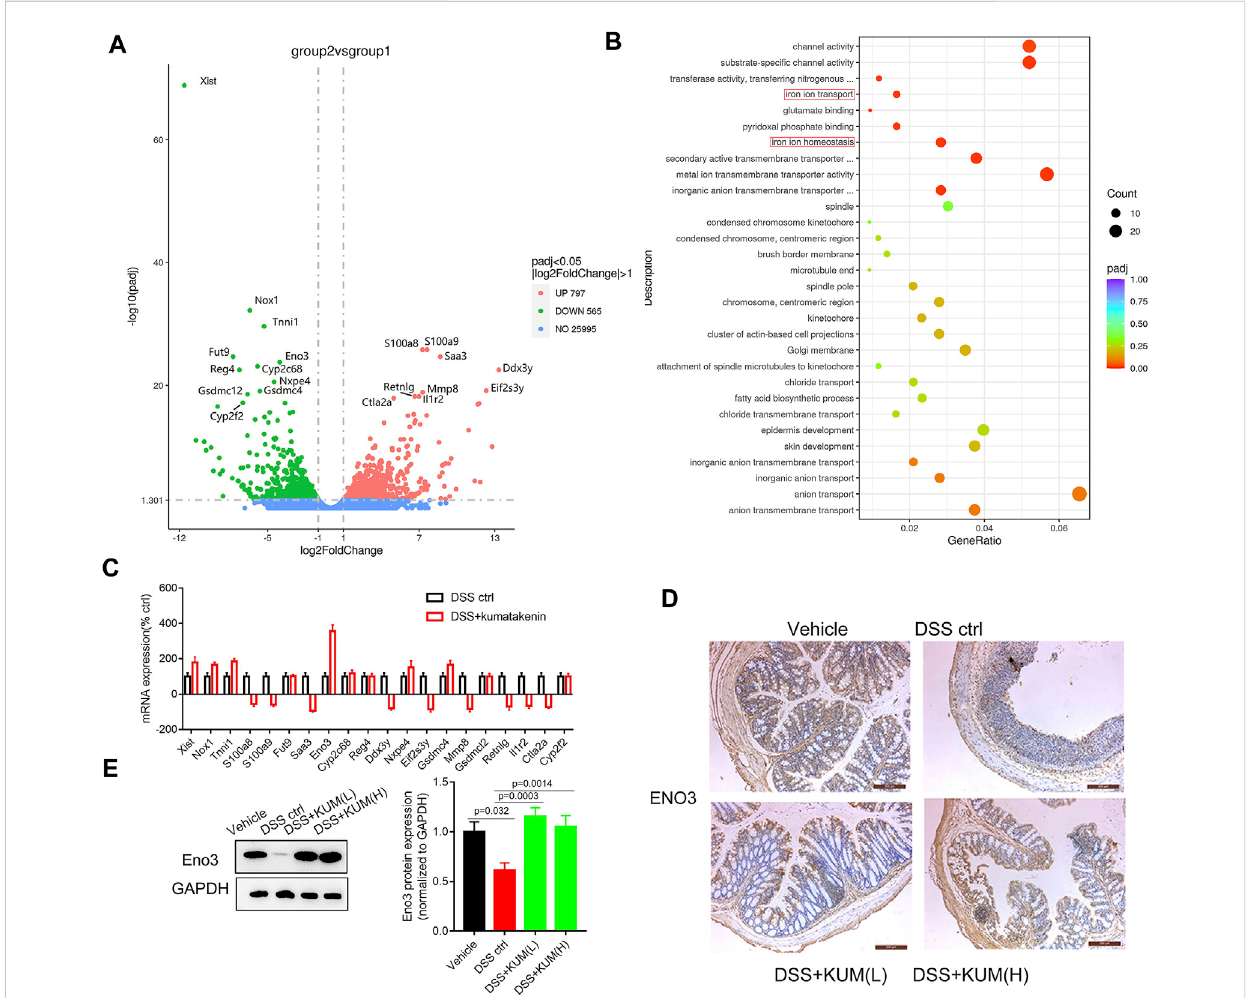
FIGURE 4 Kumatakenin suppressed ferroptosis in epithelial cells in an Eno-3 dependent manner. (A) Volcanic map of differentially expressed genes (DEGs) in colonic tissues from colitis mice following treatment with kumatakenin. (B) The most signi fi cant enrichment pathways of DEGs as determined by GO analysis. (C) qPCR veri fi cation of the top 20 most DEGs between the DSS control and DSS + kumatakenin groups. (D,E) Effects of kumatakenin on Eno3 protein expression in colitis mice (scale bar = 200 μ